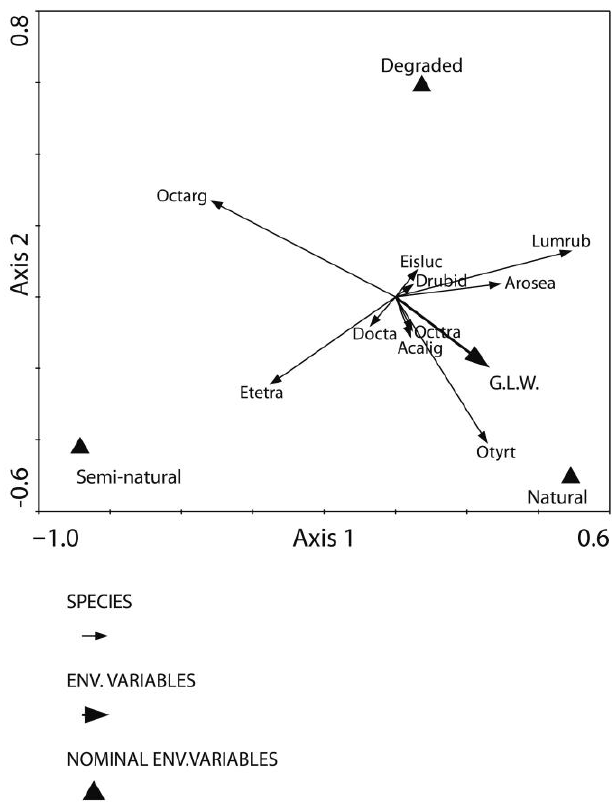
Figure 3. Ordination of earthworm community constrained by hydrologic conditions (HC) and local topography (LT) of the mountain fens of Caltho-Alnetum . pRDA model calculated with log(x + 1)-transformed species data, interspecies correlation scaling, species scores divided by SD and centered by species, not standardized by sample; time (years of study and season) and local topography used as covariates. Table 6. Effect of hydrologic conditions (HC) and fen sites on the Lumbricidae traits. Two-way nested ANOVA model calculated with log 10 (x + 1)-transformed data. F—value of partial F test